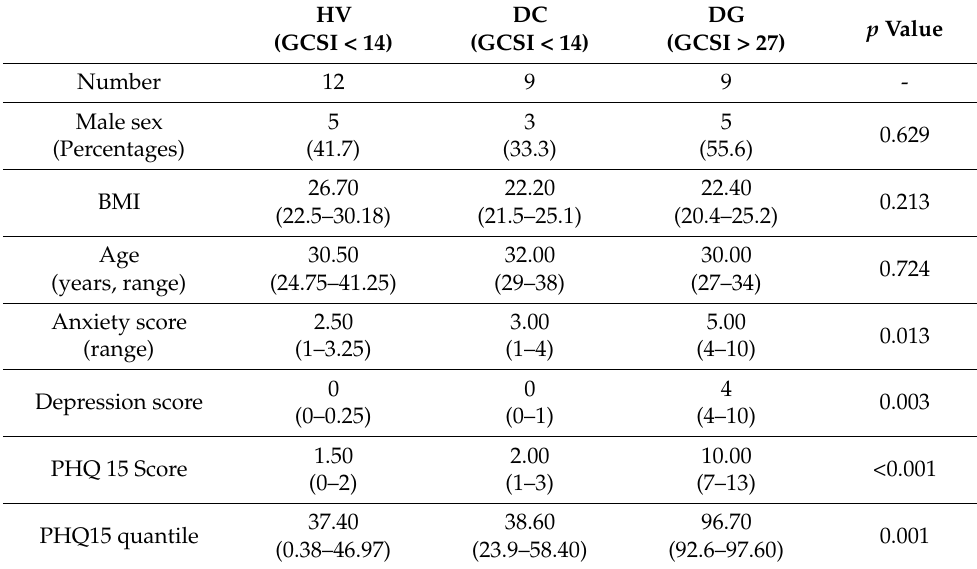
Table 1. Demographic and participants